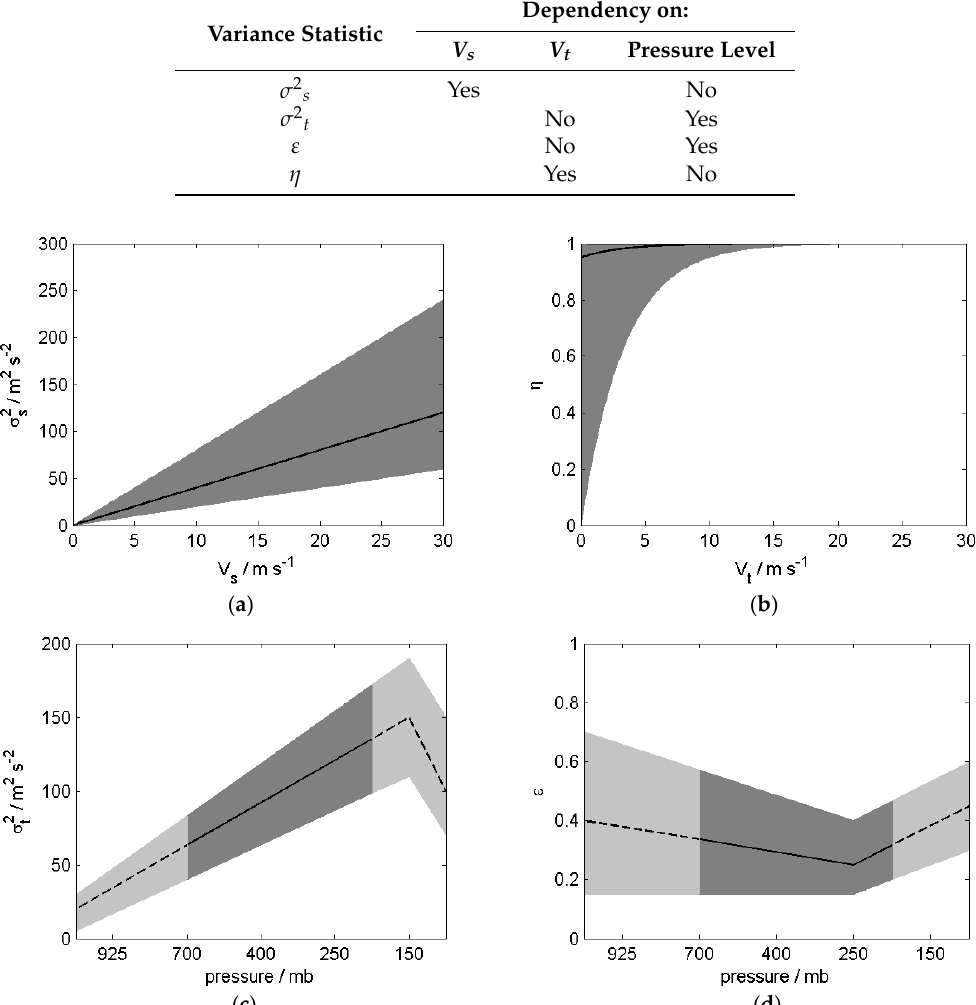
Table 4. Summary of the characteristics of σ 2 s , σ 2 t , ε , and η with respect to V s , V t and pressure level.